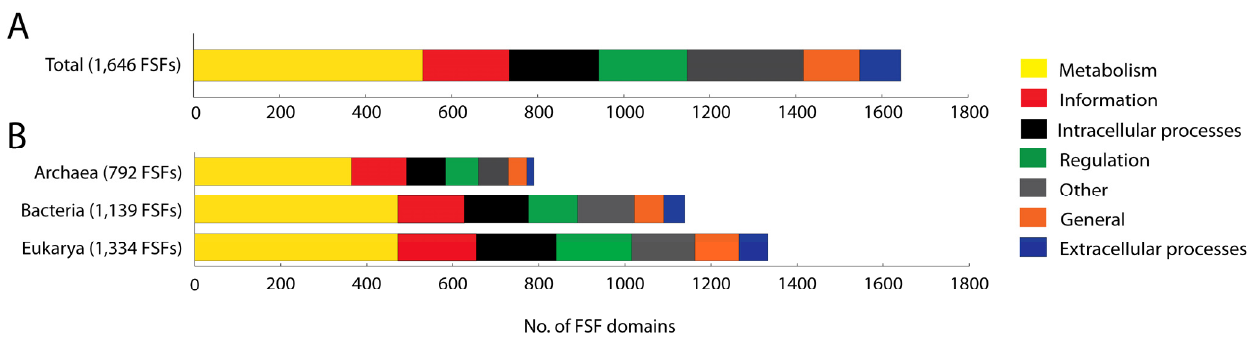
Figure 1. Number of protein FSFs annotated for each functional category defined in SCOP 1.73 ( A ) and in the three superkingdoms ( B ). The functional distributions show that coarse-grained functions are conserved across cellular proteomes and Metabolism is the most dominant functional category. Numbers in parentheses indicate the total number of FSFs annotated in each dataset. The number of FSFs increases in the order Archaea, Bacteria and